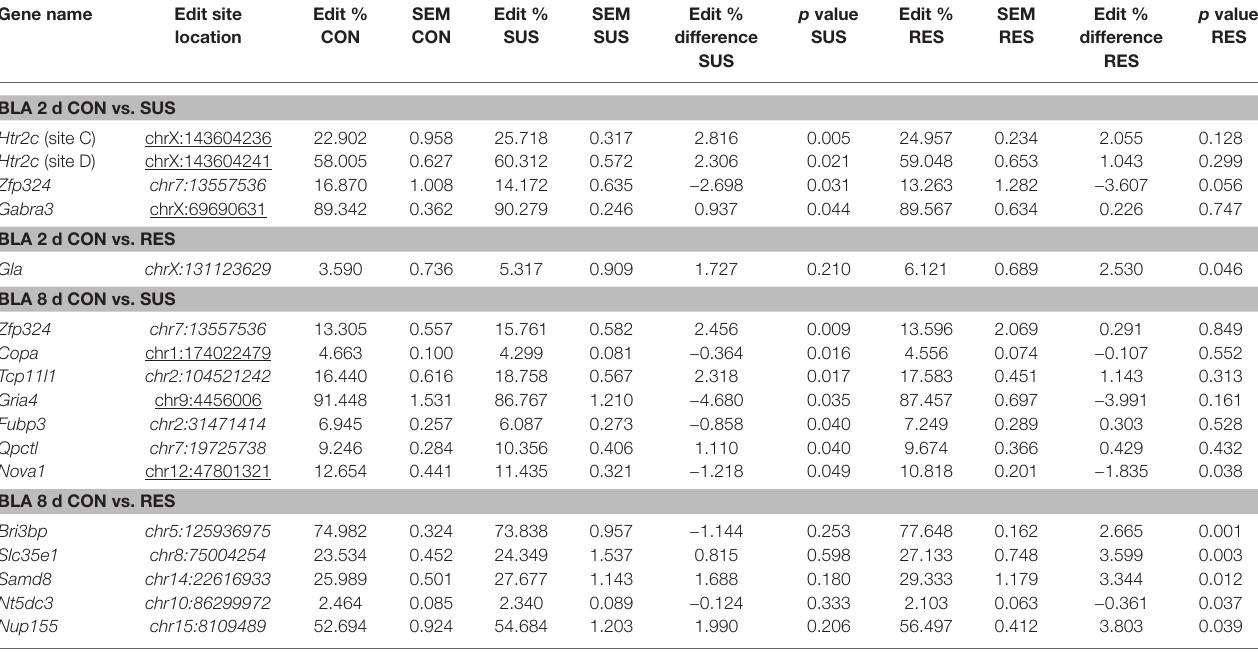
TABLE 1 | Differentially editied loci within the basolateral amygdala (BLA) following chronic social defeat stress (CSDS).